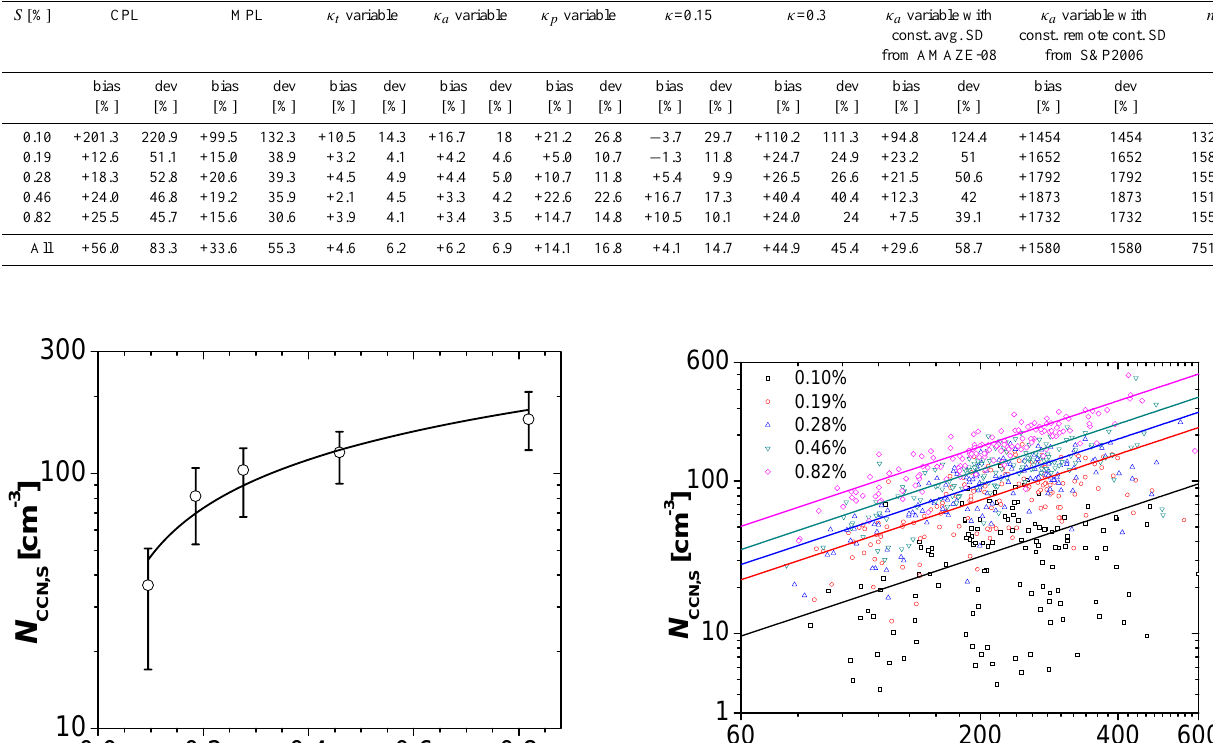
Table 4. Characteristic deviations between measured CCN number concentrations ( N CCN ,S ) and CCN number concentrations predicted by different model approaches ( N CCN ,S,p ): arithmetic mean values of the relative bias ( 1 bias N CCN ,S = (N CCN ,S,p − N CCN ,S )/N CCN ,S ) and